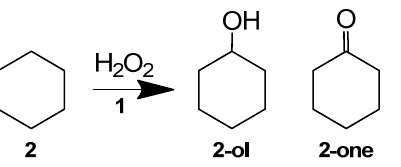
Scheme 2. Products of one slowly oxidized hydrocarbon 2